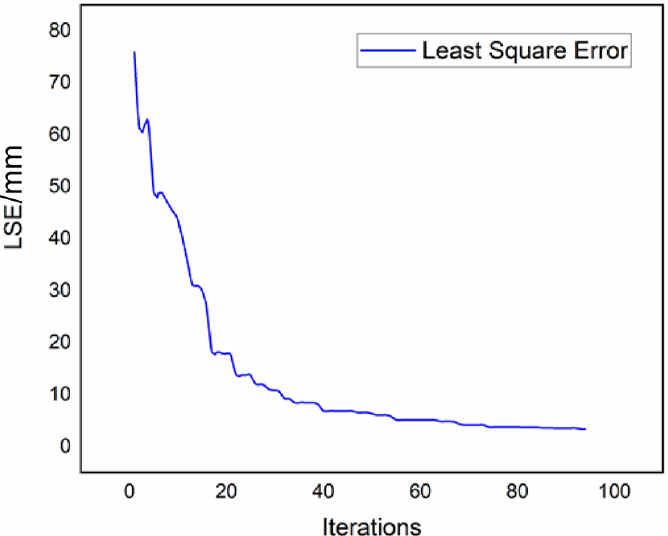
Figure 21. The iterative process of the objective function of the optimization problem.